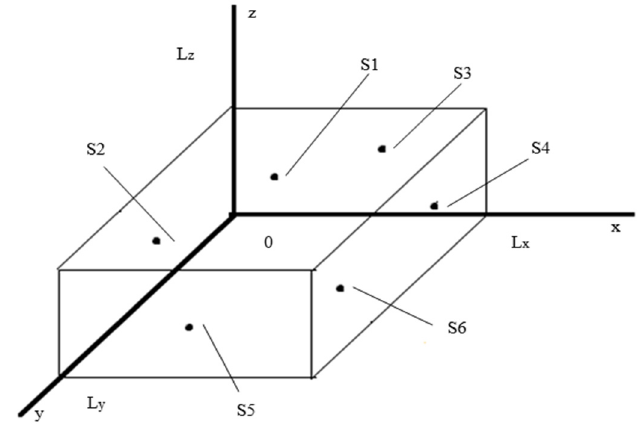
Figure 3. Reservoir model.